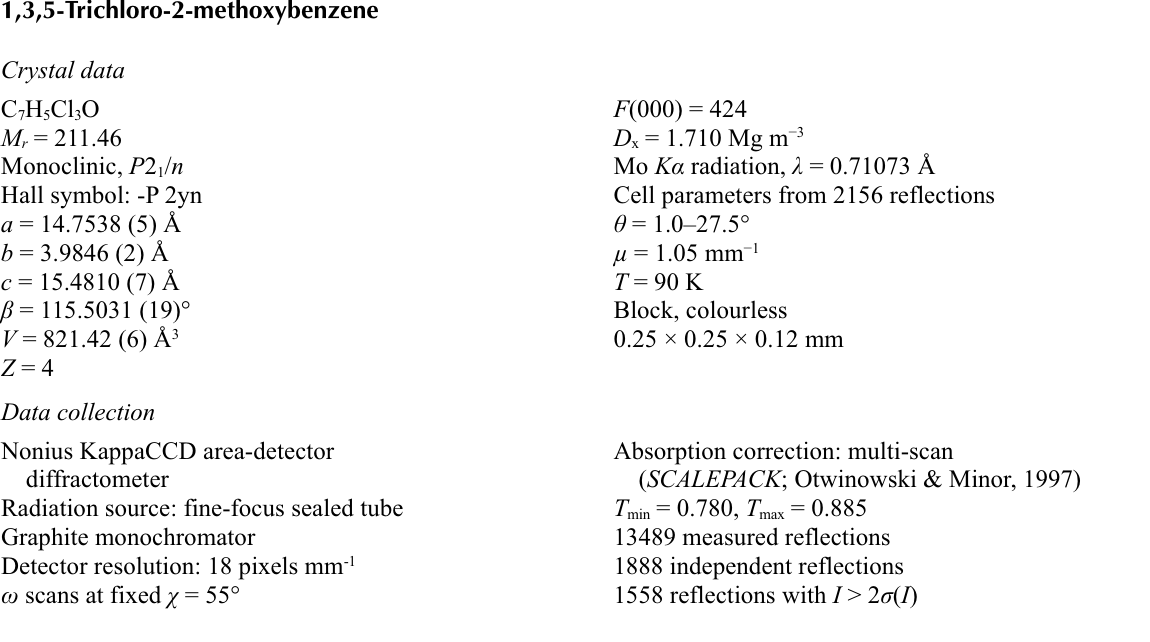
View of the title compound showing the atom-labelling scheme. Displacement ellipsoids are drawn at the 50% probability